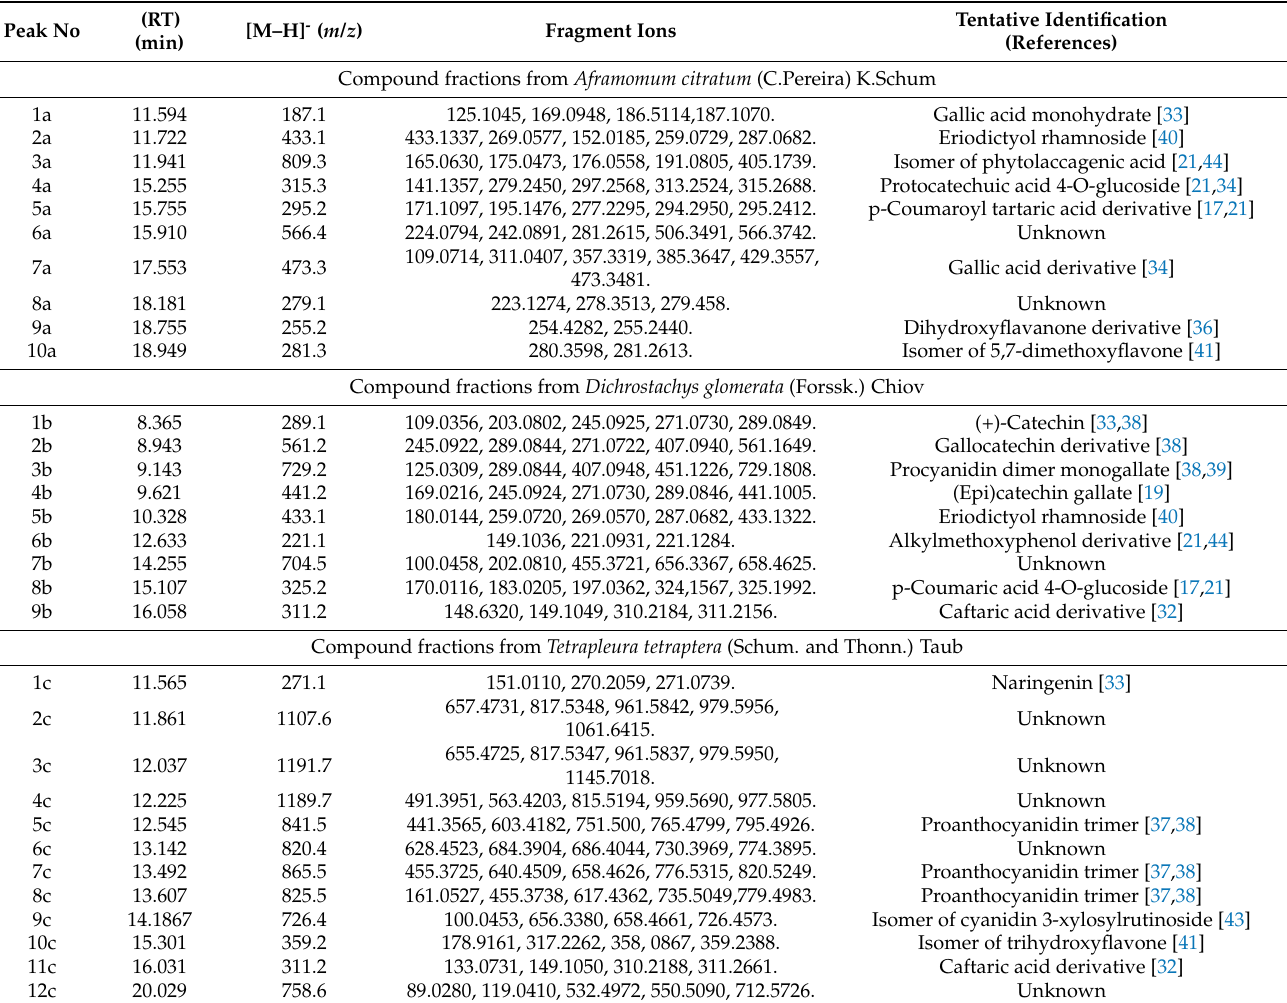
Table 1. Identification of polyphenol compounds in hydro-ethanolic extracts through UPLC-ESI- HRMS/MS